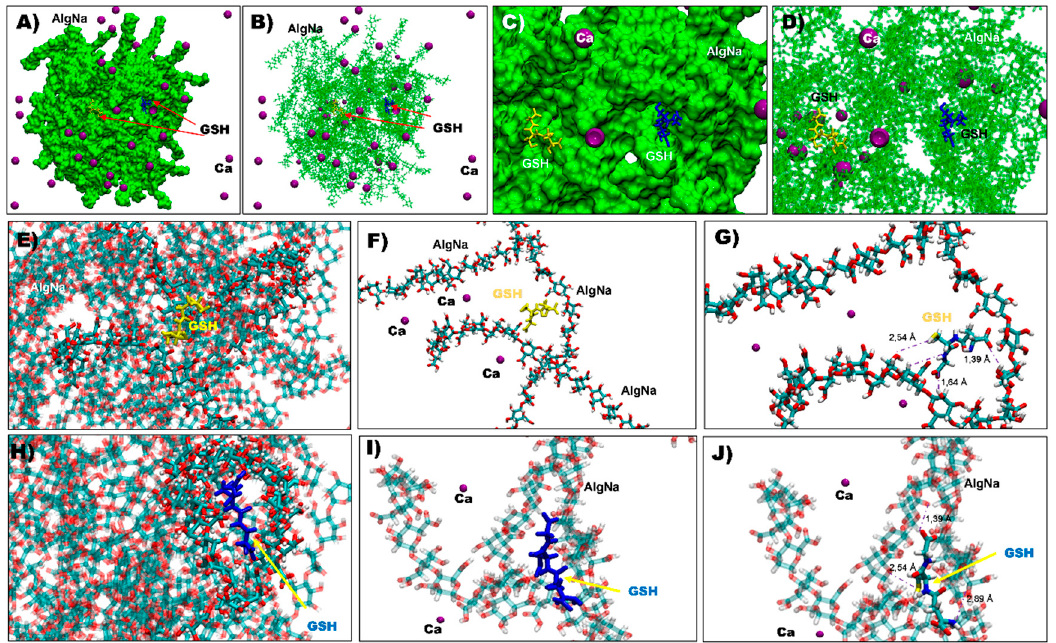
Figure 7. Alginate sphere structure interacting with GSH and calcium ions. ( A ) Complete view of the alginate sphere in a surface representation with two GSH molecules in the alginate, along with calcium ions interacting with the structure. ( B ) Licorice representation and the two GSH (in yellow and blue color) in the alginate sphere. ( C , D ) Two close views of the interaction zone of the GSH and alginates. ( E , H ) Two closed views of the interaction zone highlighting the monomer of alginates that interact with the GSH. ( F , G ) A close-up view of the first GSH that interacts with alginate. Additionally, in ( G ), the distances of the functional groups that interact between the two structures are represented. ( I , J ) The close-up view of the second GSH that interacts with alginate. Additionally, ( J ) shows the distances of the functional groups that interact between the two structures.